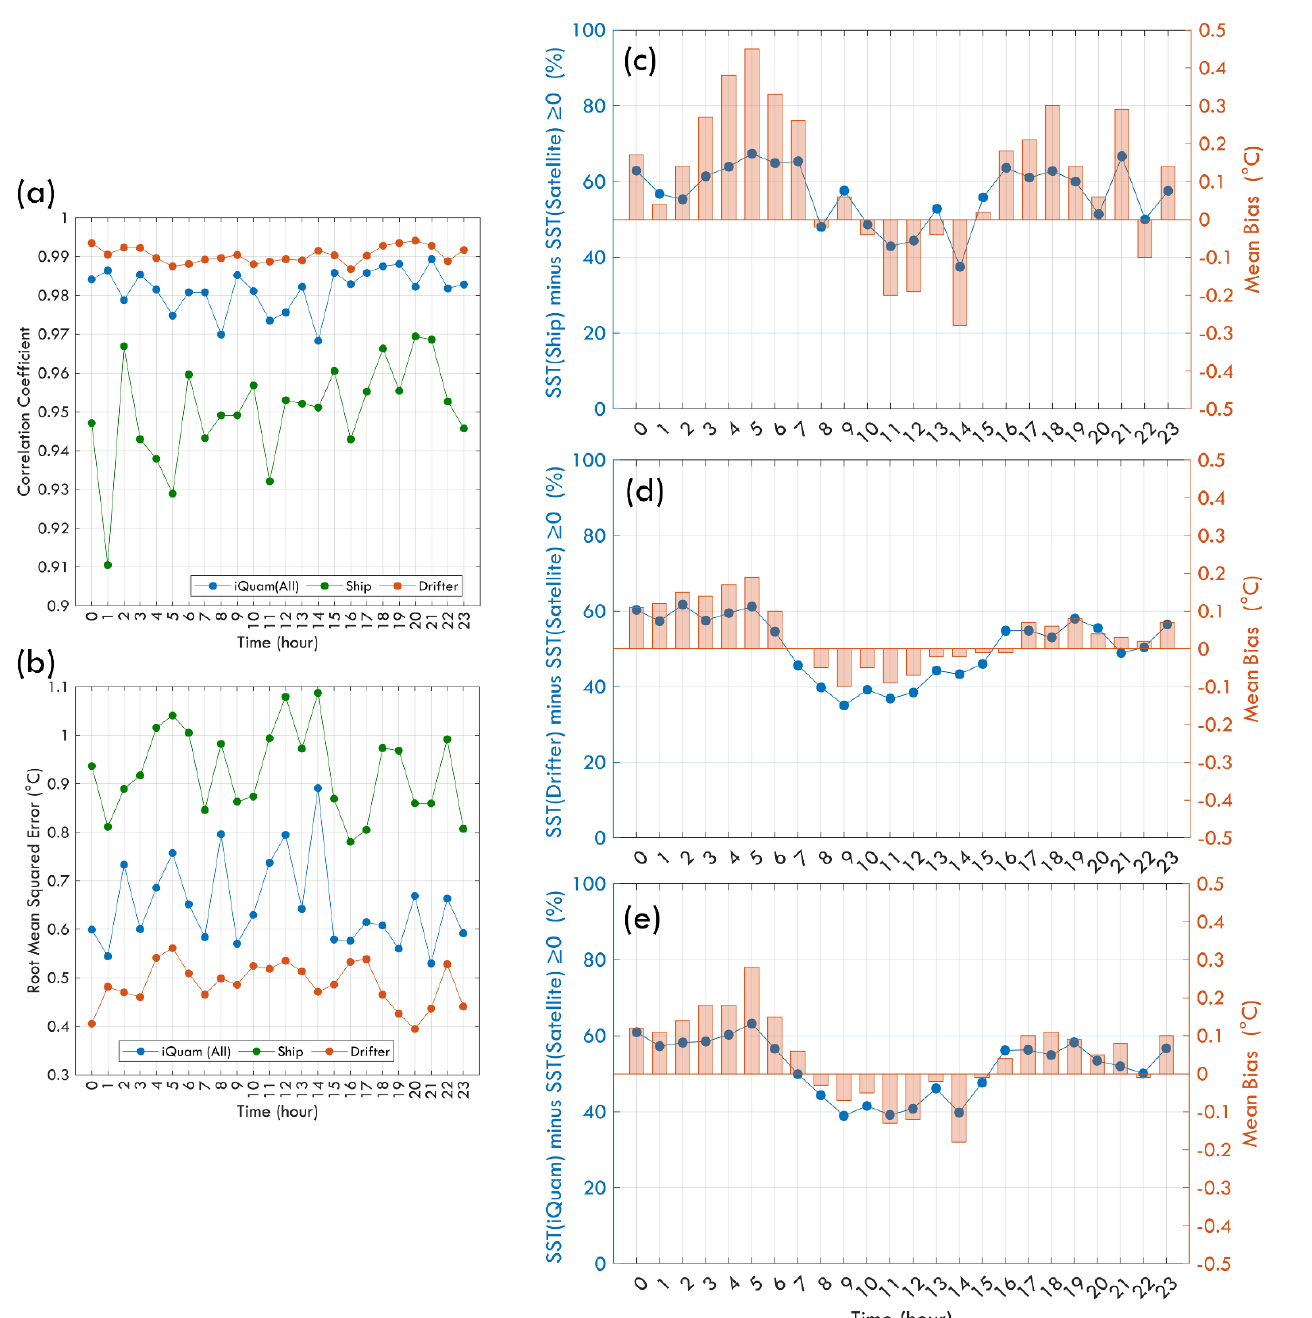
Figure 4. Comparison of bulk SST and skin SST on hourly timescales: (a) the correlation between skin SST and bulk SST, (b) the RMSE between skin SST and bulk SST, and the percentage of data that bulk SST is greater than skin SST and the mean bias between (c) ship and satellite, (d) drifter and satellite, and (e) iQuam dataset and satellite.